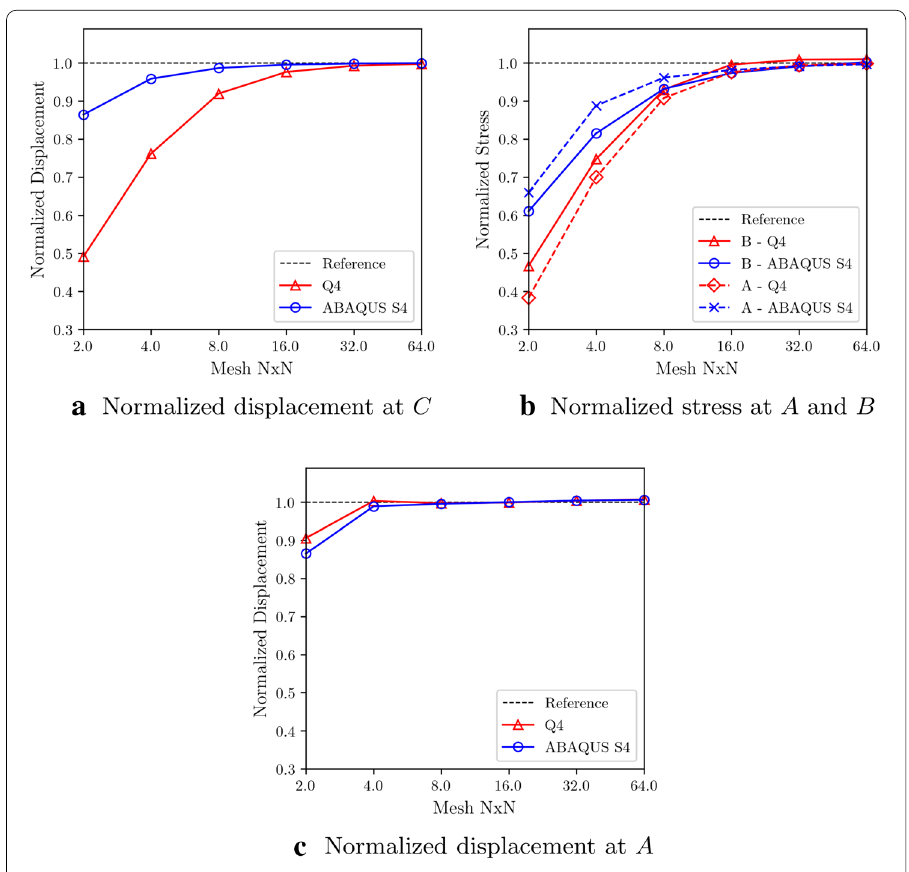
Fig. 3 Convergence plots for Cook’s trapezoidal skew beam ( a , b ) and the hemispherical shell with 18 o